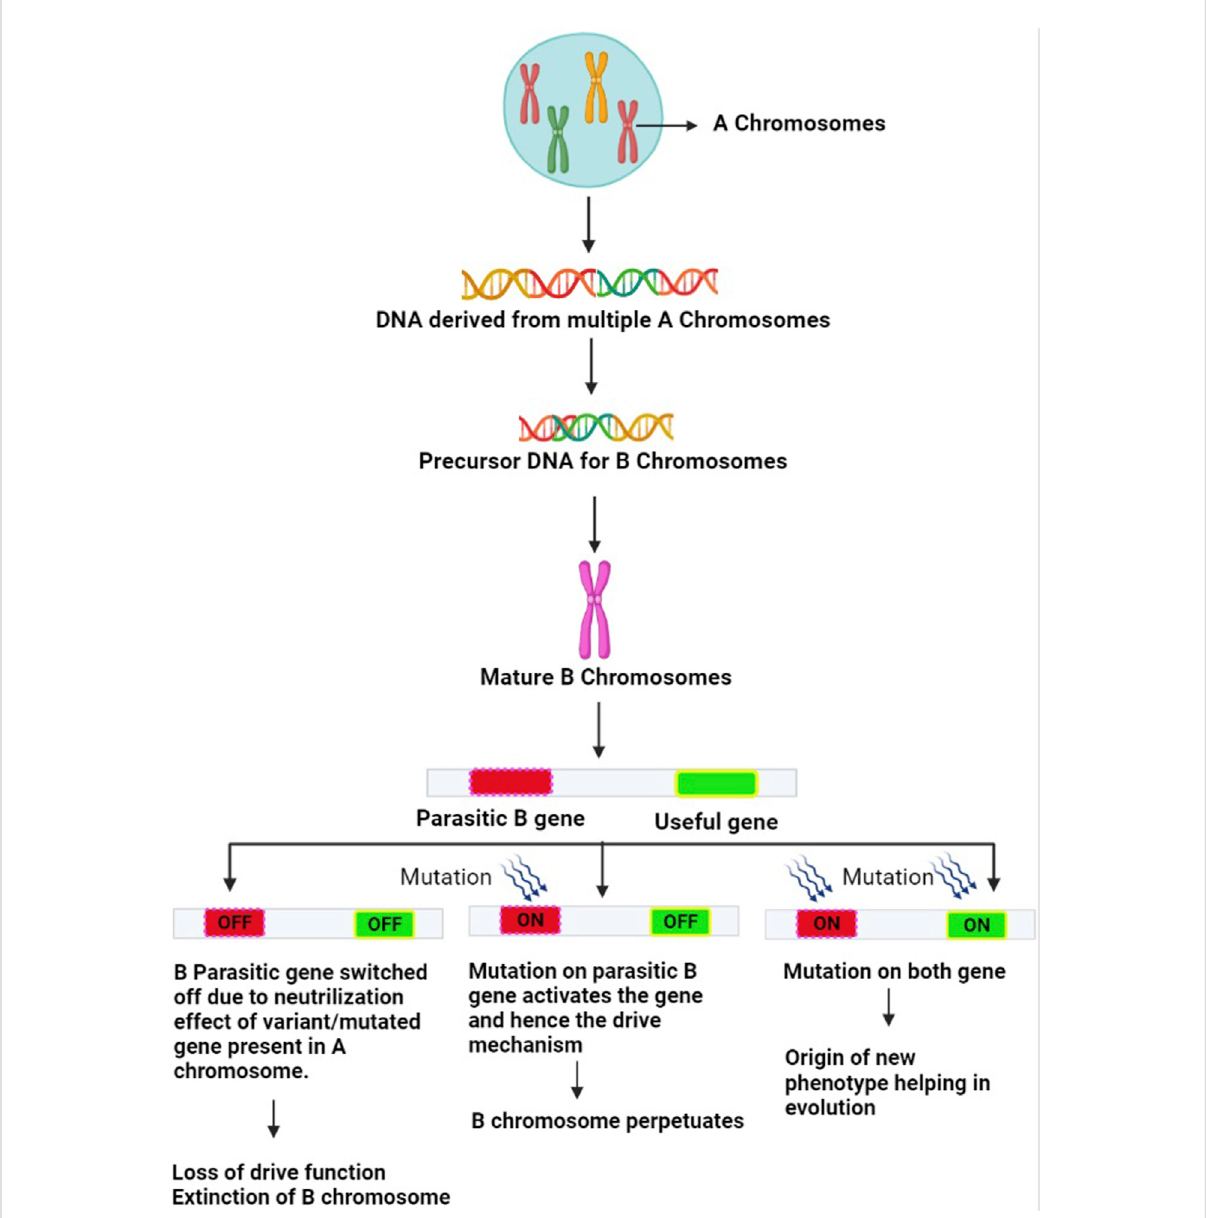
FIGURE 3 Mechanism of evolution of Bchromosomes: The A chromosome-derived Bs acquire diverse types of DNA sequences. Certain variant/mutated genes of the A genome suppress the parasitic gene on B and neutralize their harmful effects. The B-parasitic gene, however, is essential for its drive. Theremay be threeoutcomesof thissuppressionmechanism.(1) GenesonB chromosomes do not undergo anymutation, and remain switched off eventually resulting in loss of B drive furthering their extinction (2) Parasitic gene on B chromosome undergoes mutation and gets switched on to overcome the neutralizing effects of the A variant genes. This revives the B drive mechanism leading to the regeneration of B chromosomes (3) BoththeparasiticandusefulgenesonBchromosomeundergomutationsandgetswitchedon.Asaresult,thedrivemechanismbecomesactiveand Bs are regenerated and the useful gene expresses itself leading to a new phenotype that provides adaptive evolutionary advantage to the host harboring this useful mutated